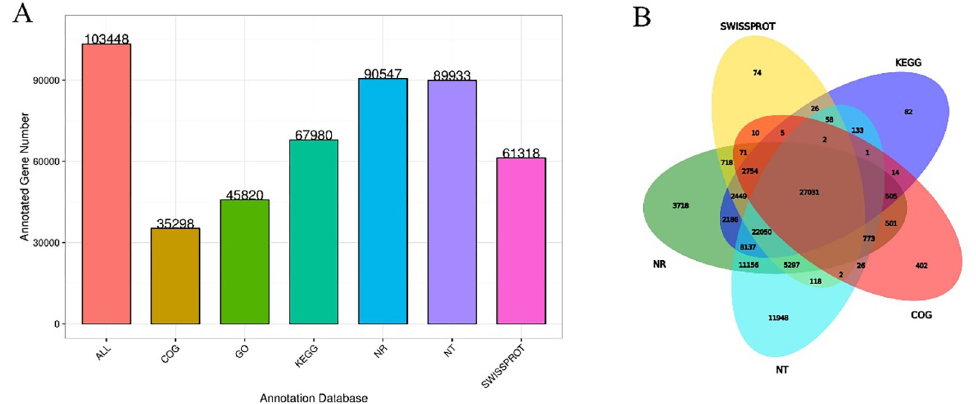
Fig 4. Unigene database statistics, functional annotations and Venn diagram. A: The X-axis represents the database, where All represents the union of all the data; the Y-axis represents the number of unigenes in the corresponding database annotation, and the number in the figure corresponds to the number of unigenes in the annotation. B: Venn diagram showing the number of specific genes between the two samples.